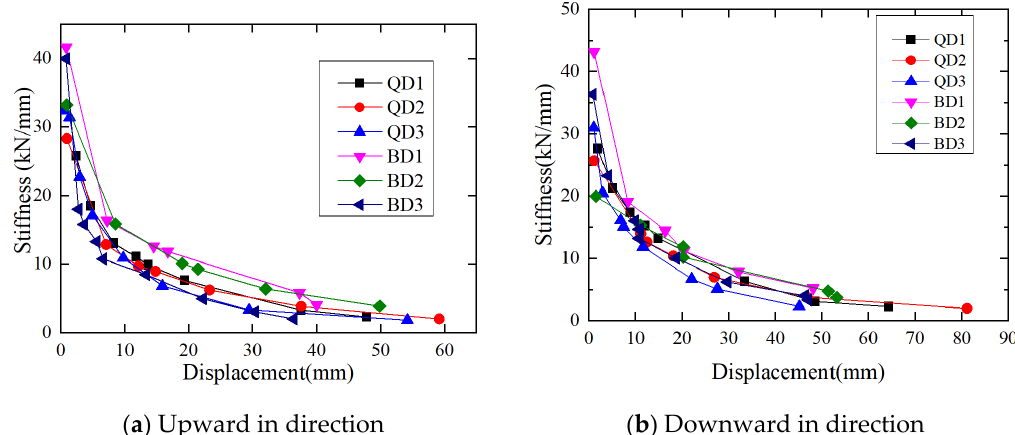
Figure 8. Stiffness degradation of the six specimens in two directions. ( a ) upward in direction; ( b ) downward in direction.